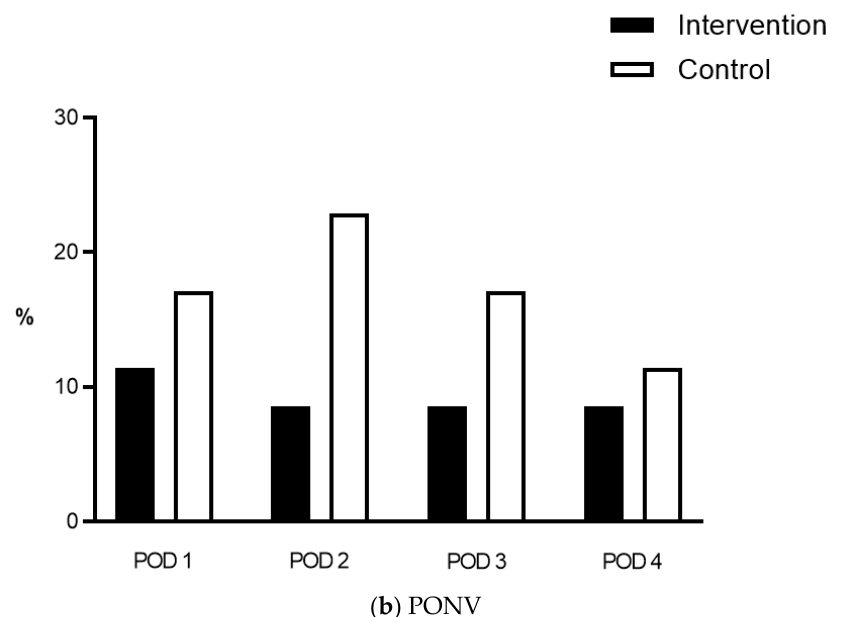
Figure 3. Postoperative pain and nausea: ( a ) Evolution of postoperative pain scores over time. Displayed are mean scores (dots) with S.E.M.; VAS—visual analog scale (0–10), POD—postoperative day S.E.M.—standard error of the mean; ( b ) Percentage of patients presenting with postoperative nausea in patients in the intervention group (black bars) and patients in the control group (white bars). PONV—postoperative nausea and vomiting, POD—postoperative day. Satisfaction scores with doctors and nurses were high through all categories and similar between both groups (Figure 4). Regarding hospital services and care, the items access and comfort/cleanliness were rated higher by the IG. Finally, OR reception and comfort/cleanliness were also rated significantly higher by the IG, while overall satisfaction was similar (90 ± 15 vs. 82.9 ± 16, p = 0.057). Preoperative information by the operating